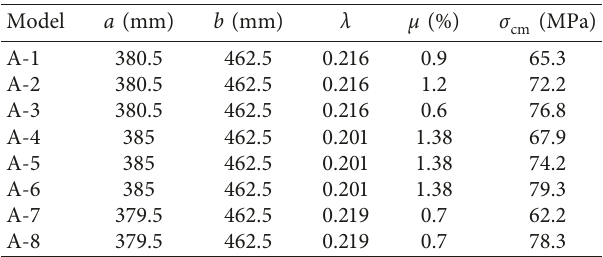
Table 4: Model parameters.